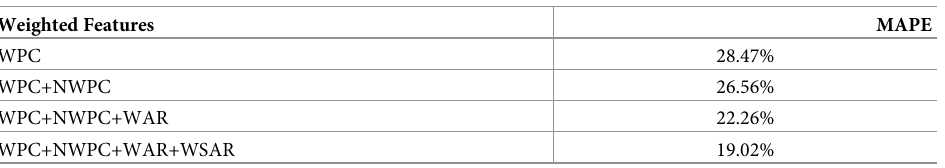
Table 7. Performance due to the usage of multiple weighted features.